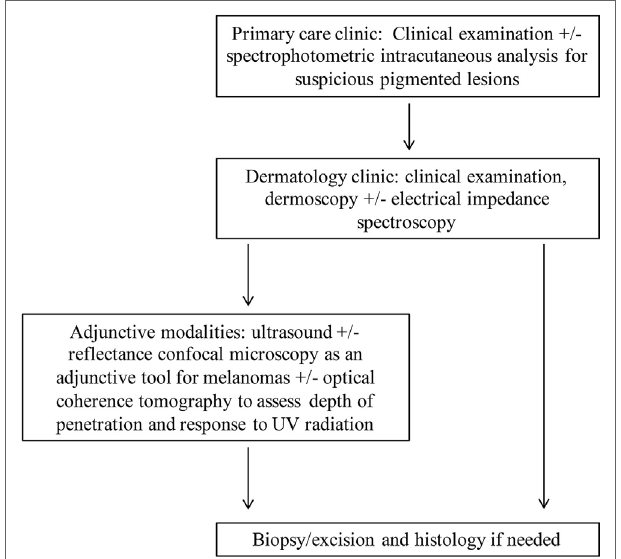
FigURe 6 | A proposal of a novel approach for examination of cutaneous diseases. Spectrophotometric intracutaneous analysis may be useful for primary care physicians in considering lesions before referral. Clinical visualization and dermoscopy are always the first component of the examination of a lesion. Some literature suggests that electrical impedance spectroscopy can aid in the decision-making process regarding excision. Ultrasound can be incorporated next with modification of frequency parameters to obtain optimal penetration depth; ultrasound features such as color Doppler for assessment of lesion vascularity can be used as needed. Reflectance confocal microscopy and optical coherence tomography may be helpful in specific cases, and biopsy and histopathology remain the final step if further diagnostic clarification is